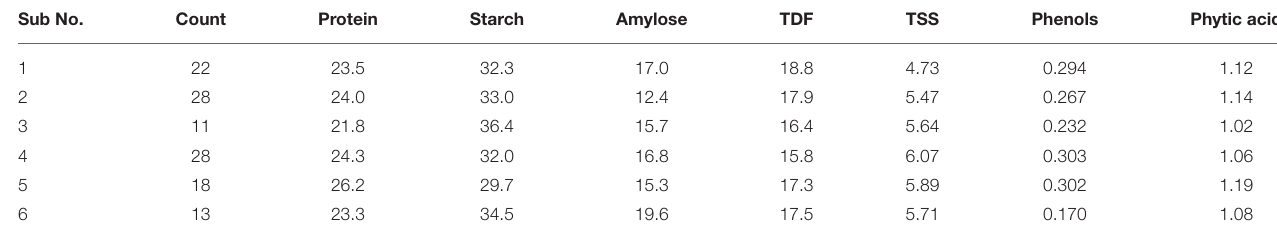
TABLE 4 | Number of accessions and mean values of six clusters for seven different biochemical traits. Sub No.